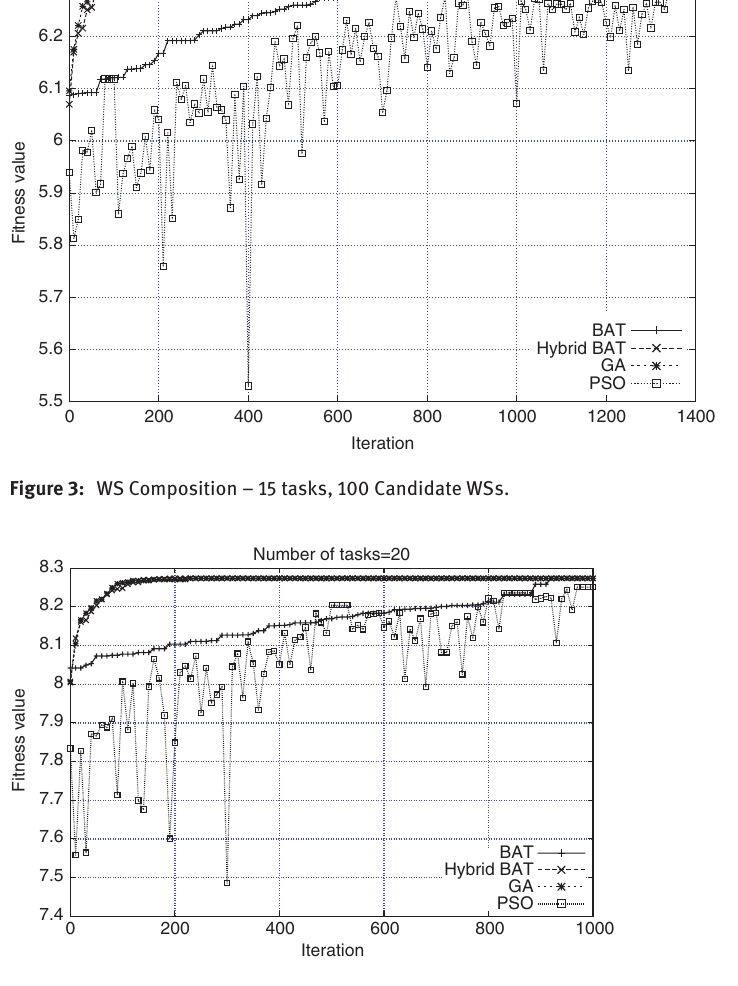
Figure 4: WS Composition – 15 tasks, 100 Candidate